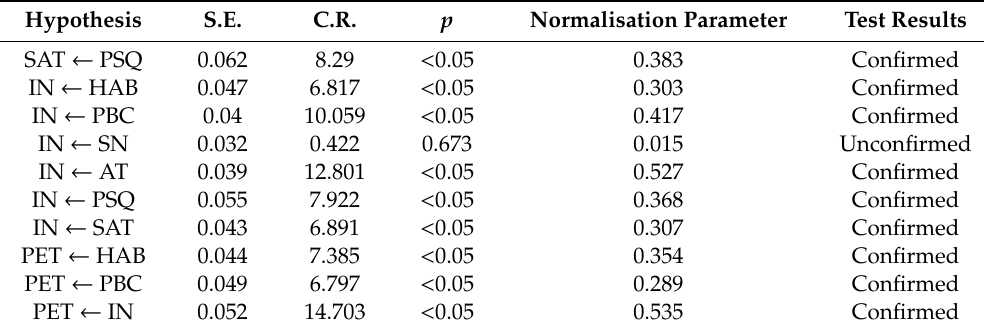
Table 4. Summarisation of the outcomes for the hypotheses.